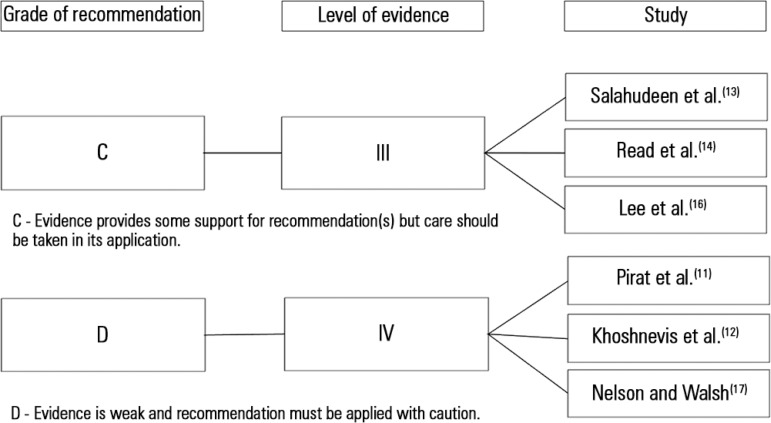
National Health and Medical Research Council additional levels of evidence and
grades for recommendations for developers of guidelines.